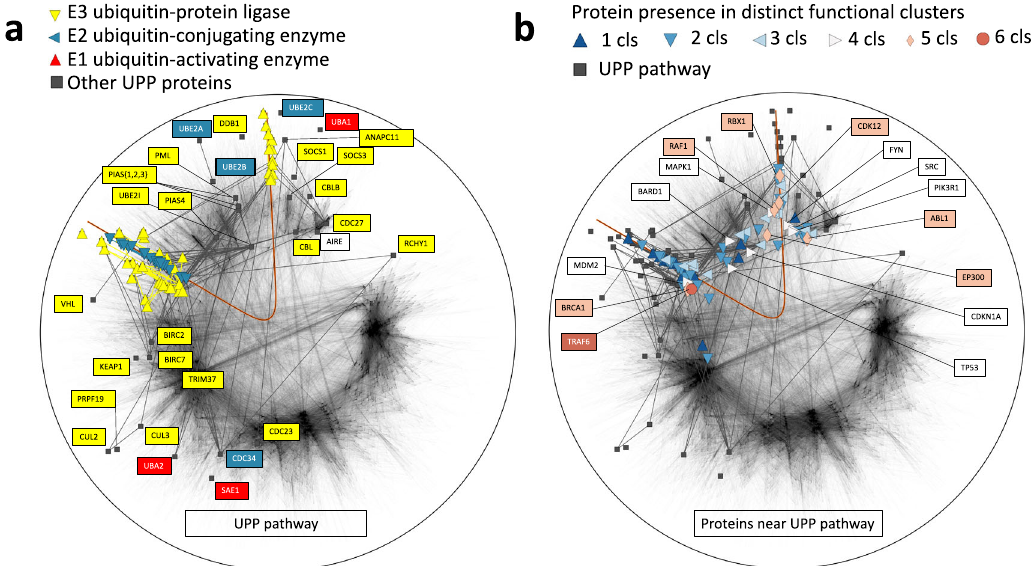
Fig. 5 | Latent-geometric localization of the ubiquitin-proteasome pathway ( UPP ) pathway. a the hyperbolic map of the similarity-based human protein- protein interaction (PPI) network and the UPP pathway. Pathway proteins are colored according to their functional groups, background nodes are non-pathway proteins comprising the network. E1, E2, and E3 are the three classes of enzymes associated with ubiquitination: E1 and E2 correspond to ubiquitin-activating and